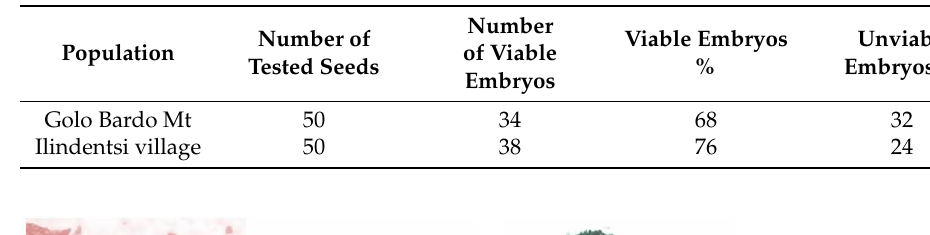
Table 2. Assessment of the seeds (embryos) viability after TZ testing for seeds collected from the plants at the experimental plots (ex situ).